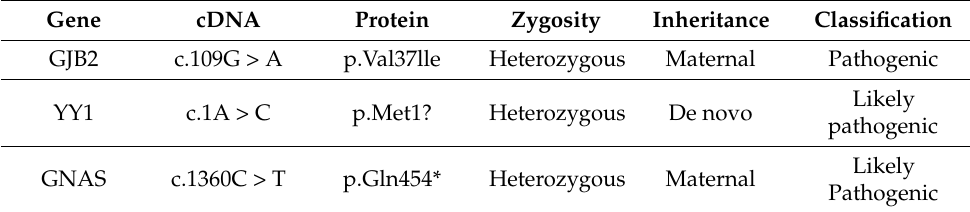
Table 1. Summary table of the whole-genome sequencing–variants c.1A > C and c.1360C > T have not been characterized in the